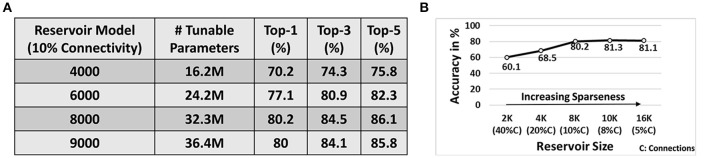
(A) Top-1/3/5 accuracy on 101-classes obtained with 8-training example (per class) learning for D/A models of different topologies. (B) Effect of variation in sparsity (for fixed 1 : 800 number of connections per neuron across different reservoir topologies) on the Top-1 accuracy achieved by the reservoir. Note, all results are performed on the D/A reservoir scheme with 8 training videos per class processed with the input spike transformation technique mentioned earlier.